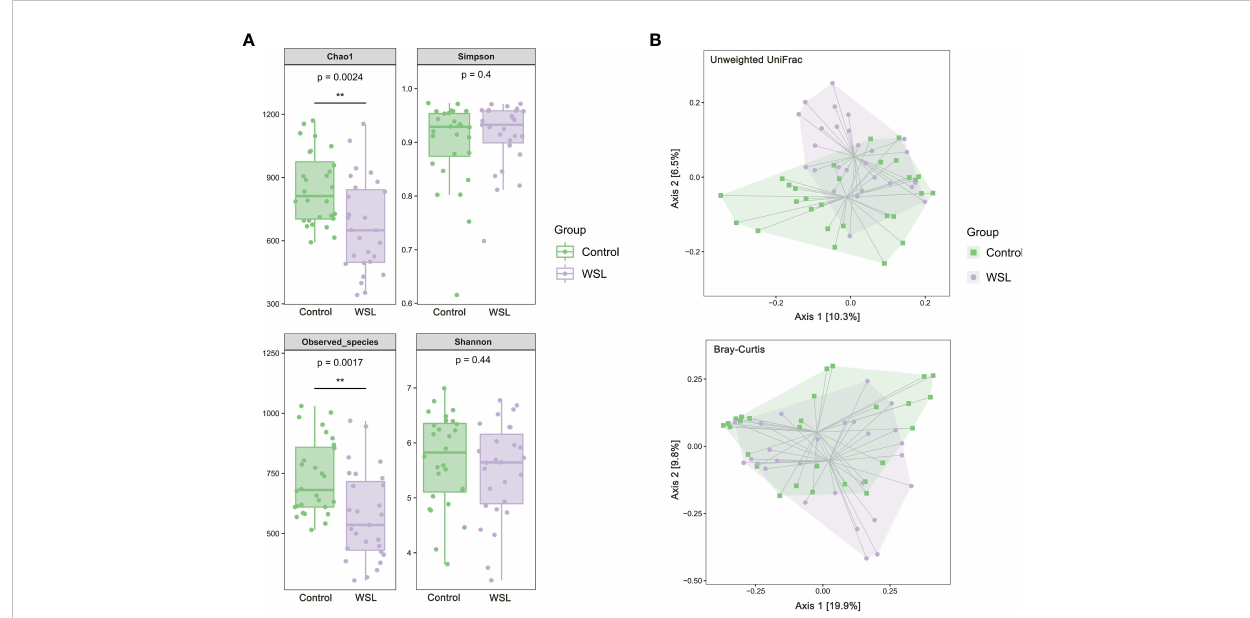
FIGURE 1 Microbial diversity analysis. (A) Box plots of alpha diversity of salivary microbiota in the control and WSL groups. Left: Chao1 and Observed_species indices; right: Shannon and Simpson indices (**p < 0.01, Kruskal-Wallis). (B) PCoA plot based on the unweighted UniFrac and Bray-Curtis distances. A certain trend of clustering and separation of samples was identi fi ed when comparing the control and WSL groups (p < 0.05,